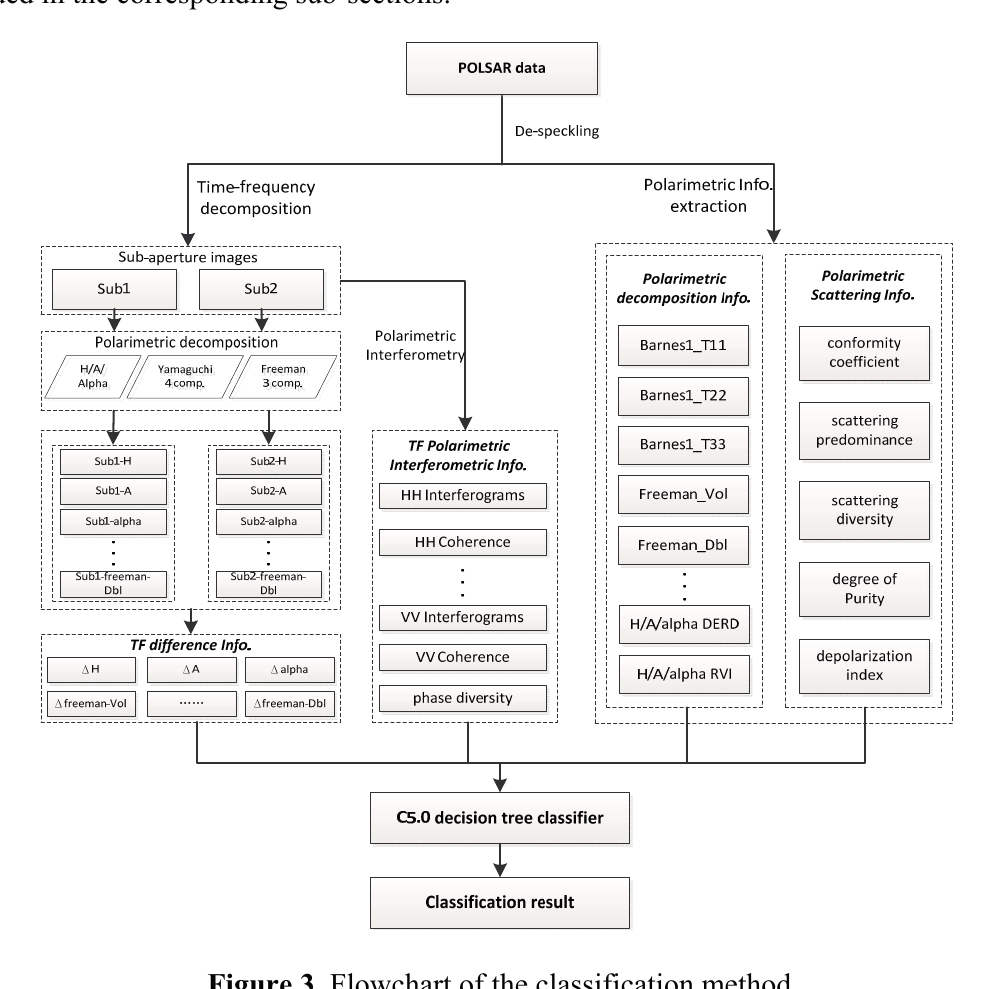
Figure 3. Flowchart of the classification